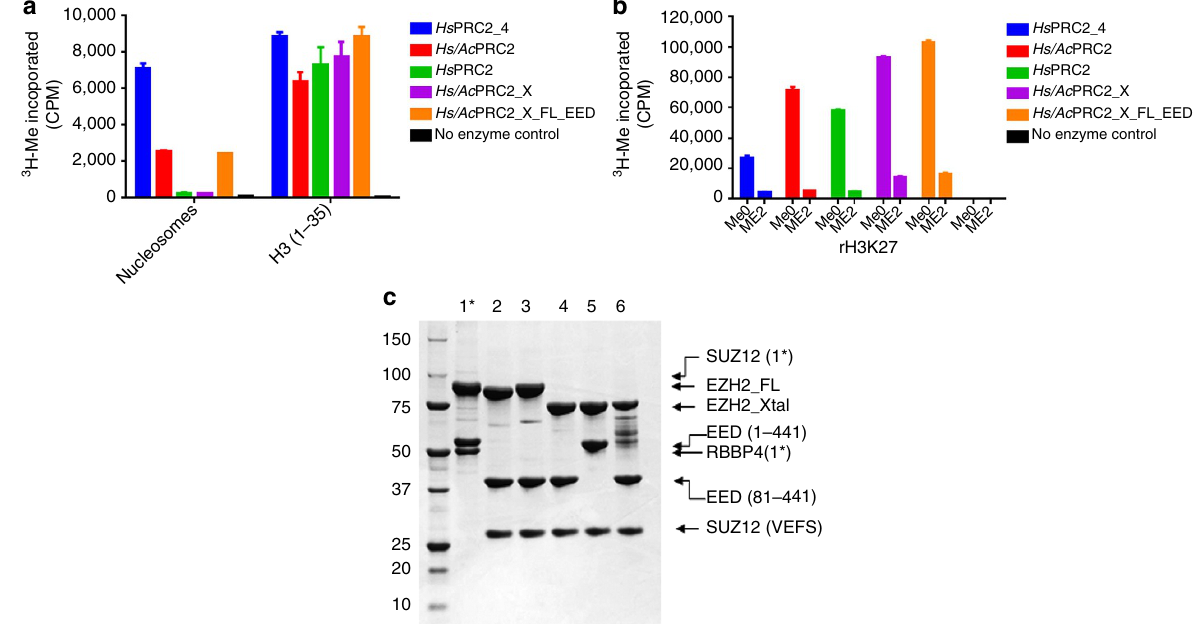
Figure 2 | Biochemical characterization of PRC2. ( a ) PRC2 methyltransferase activity on in-house nucleosomes (see the ‘Methods’ section) and H3 peptide (1–35; Anaspec); Hs/Ac PRC2_X is the crystallized PRC2 and Hs/Ac PRC2_X_FL_EED is with full-length EED. ( b ) PRC2 methyltransferase activity on rH3Me0 (NEB) and rH3Me2 (Active Motif). Total counts at 30min from three separate experiments are plotted as mean ± s.d. ( c ) SDS-PAGE analysis of PRC2 complexes used for biochemical analysis: lane 1—intact Hs PRC2_4 (full-length EZH2 (EZH2_FL) and SUZ12 co-migrate on SDS-PAGE due to similar molecular weight; additional band below EED is RBBP4), lane 2— Ac PRC2, lane 3— Hs PRC2, lane 4— Hs/Ac PRC2_X, lane 5— Hs/Ac PRC2_X_FL_EED ( Hs / Ac PRC2_X with full-length EED), lane 6—Y641N Hs/Ac PRC2_X (protein degradation observed for Y641N PRC2_X is consistent with dynamic nature of this protein which leads to susceptibility to proteolysis) proteins used for crystallization and biochemical assays (5 m g per lane; previously frozen at (cid:2) 80 (cid:2) C).